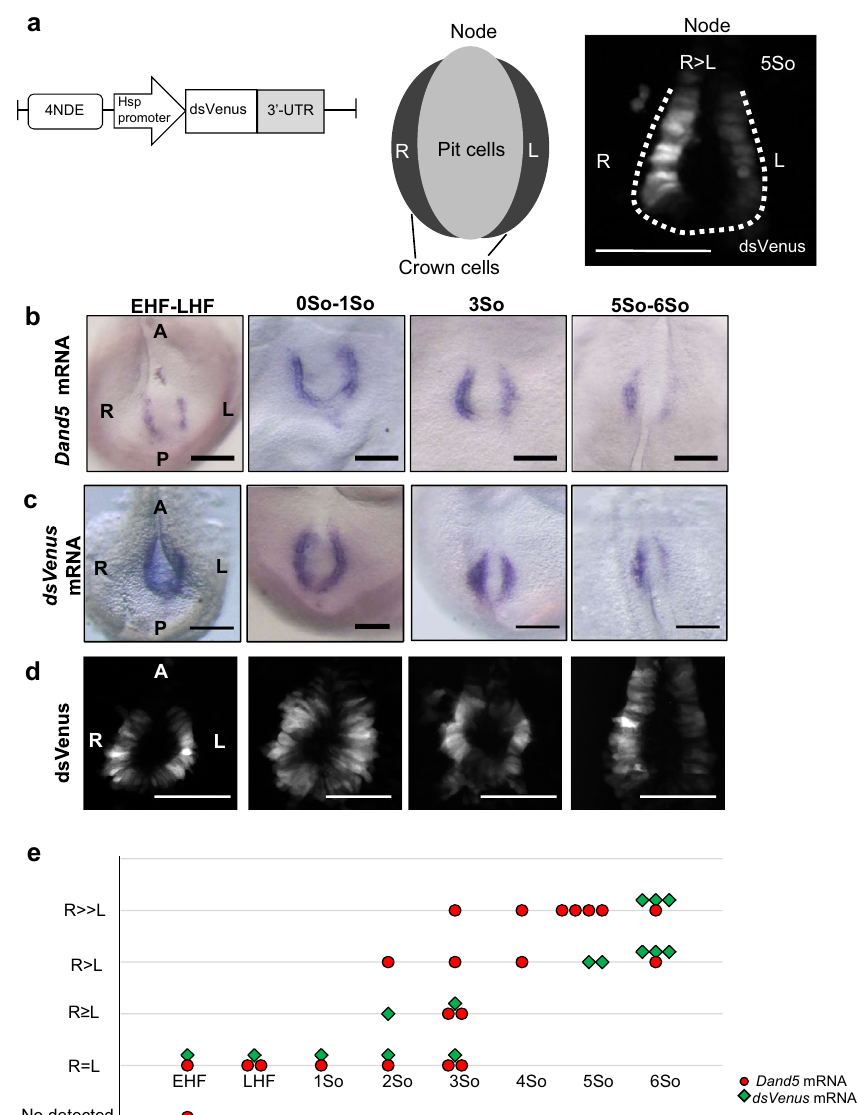
Fig. 1 A 3 ′ -UTR reporter recapitulates the asymmetric distribution of Dand5 mRNA at the node. a Schematic representation of the NDE-Hsp-dsVenus-3 ′ - UTR transgene (left) and of the relative localizations of pit cells and crown cells at the node of mouse embryos (middle). The transgene contains the ORF for dsVenus linked to the DNA sequence for the 3 ′ -UTR (1.2 kb) of mouse Dand5 mRNA, and its expression is driven by the mouse Hsp68 promoter and four copies of the crown cell – speci fi c enhancer (NDE) of mouse Nodal . A typical pattern of dsVenus fl uorescence detected at the node of a transgenic embryo at the fi ve-somite (5So) stage is also shown (right), with the dashed line indicating the node region. Note that the fl uorescence in crown cells is highly L-R asymmetric (R > L). Scale bars, 100 µ m. b Whole-mount in situ hybridization (WISH) analysis of Dand5 mRNA at the node of wild-type mouse embryos at the indicated developmental stages. Note that Dand5 mRNA in crown cells is bilaterally equal at the early headfold (EHF) to late headfold (LHF) stages as well as the zero- to one-somite stages, but is asymmetric (R > L) at the three-somite and fi ve- to six-somite stages. A and P, anterior and posterior, respectively. Scale bars, 100 µ m. c WISH analysis of dsVenus mRNA in NDE-Hsp-dsVenus-3 ′ -UTR transgenic embryos at the indicated stages. Scale bars, 100 µ m. d Fluorescence images of dsVenus at the node of transgenic embryos at the indicated stages. Scale bars, 100 µ m. Images shown in ( b – d ) are representative of at least two embryos at each stage. e Comparison of L-R asymmetry of Dand5 mRNA in wild-type embryos and dsVenus mRNA in transgenic embryos at various developmental stages. Each point corresponds to one embryo. Note that the pattern of dsVenus mRNA recapitulates that of Dand5 UTR- Δ 200prox transgene yielded bilaterally symmetric dsVenus editing to delete this proximal 200-nucleotide region of the fl uorescence at the node (Fig. 3b, and Supplementary Fig. 1b) ( n Dand5 3 ′ -UTR in the mouse genome, thereby generating the = 5/6). On the other hand, deletion of the 3 ′ -most 200 nucleo- Dand5 Δ 200prox allele (Supplementary Fig. 3). WISH analysis revealed that whereas bilateral Nodal expression at the node was tides from the 3 ′ -UTR ( Δ 200dist in Fig. 3a) did not perturb maintained, left-sided Nodal expression in lateral plate mesoderm asymmetric dsVenus fl uorescence (Fig. 3b) ( n = 3/3). Further- (LPM) was lost in Dand5 Δ 200prox/ Δ 200prox embryos ( n = 4/4) more, the 5 ′ -most 200 nucleotide region ( 200prox in Fig. 3a) (Fig. 3c), as expected if Dand5 mRNA remains stable on both alone gave rise to asymmetric dsVenus fl uorescence ( n = 4/5) sides of the node. Among eight Dand5 Δ 200prox/ + embryos (Fig. 3b). Prompted by these results, we applied CRISPR-based